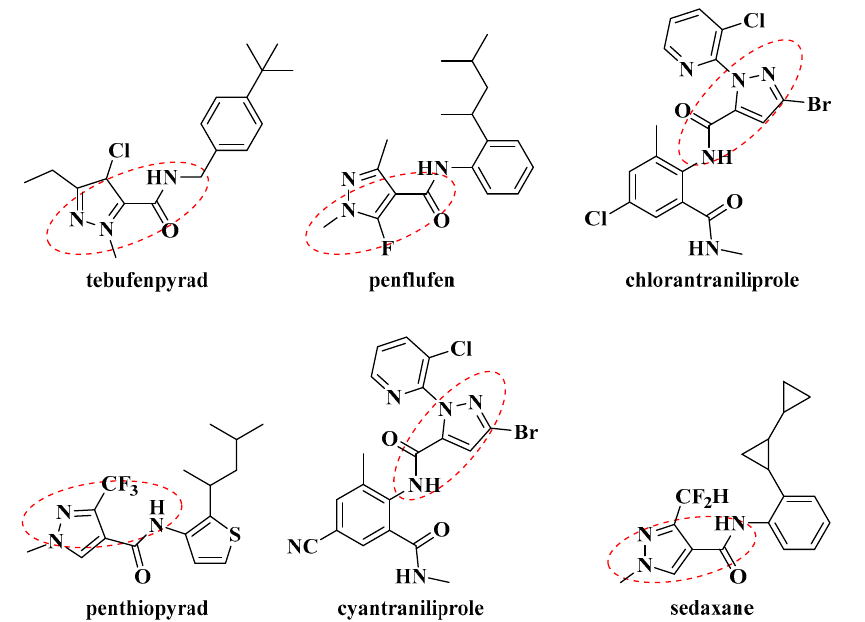
Figure 1. Chemical structures of tebufenpyrad, penflufen, chlorantraniliprole, penthiopyrad, cyantraniliprole and sedaxane.